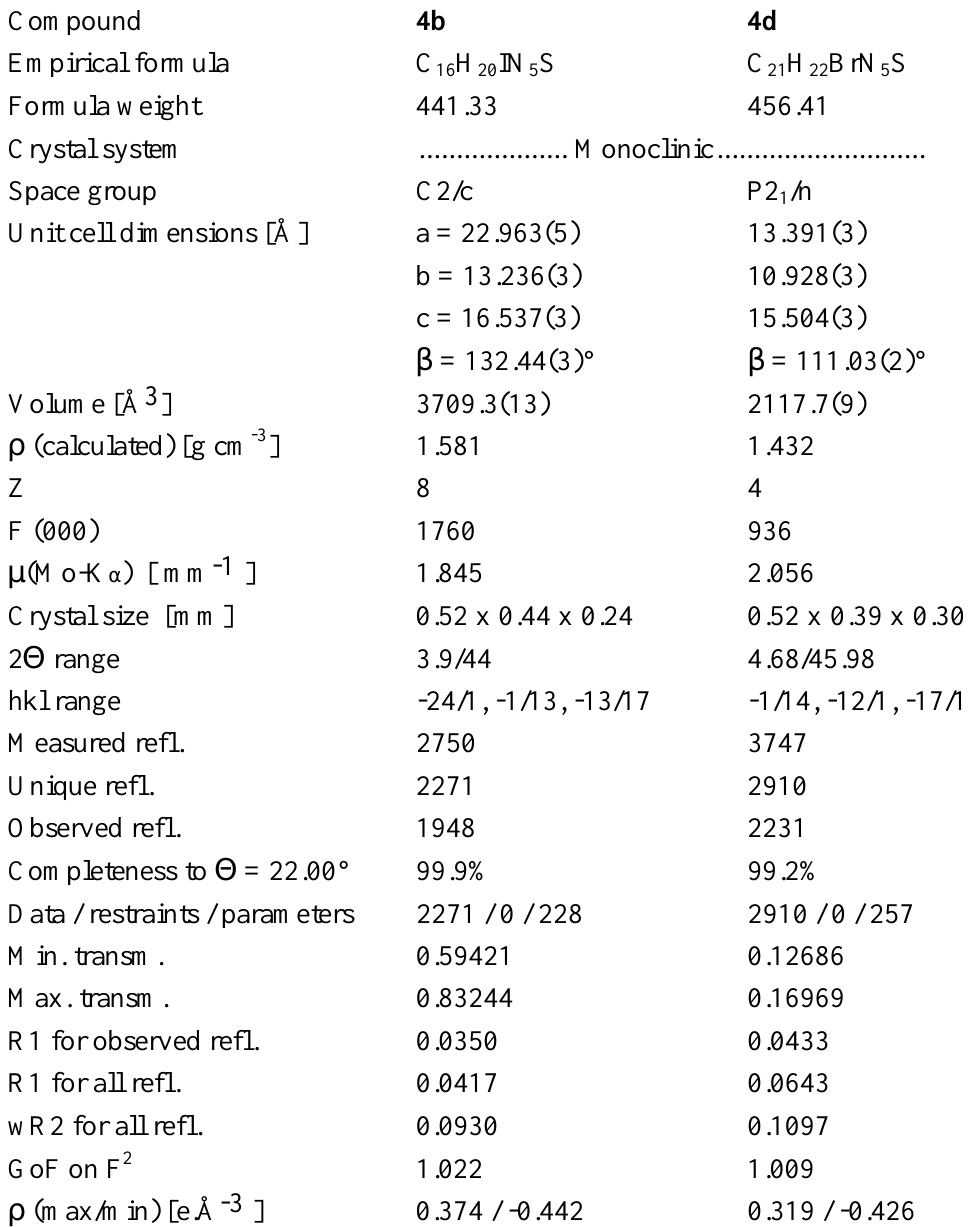
Table 3. Selected bond lengths [in Å], bond angles [in